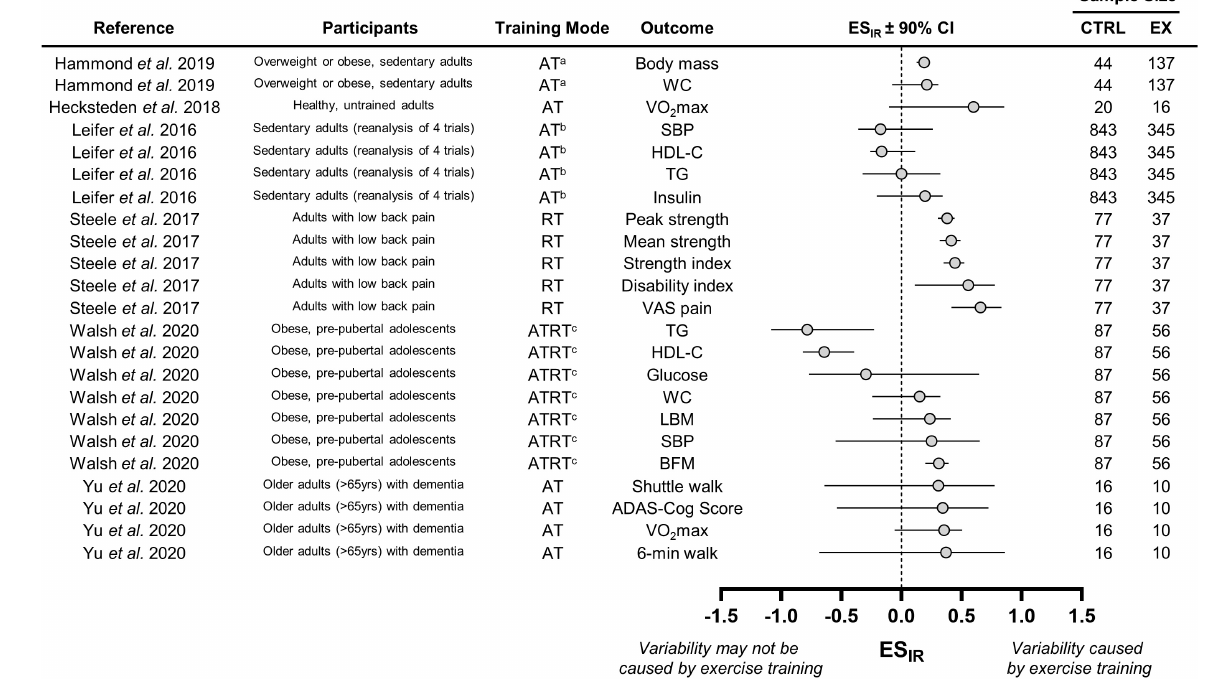
compared with treatment groups (Winkelbeiner et al.,